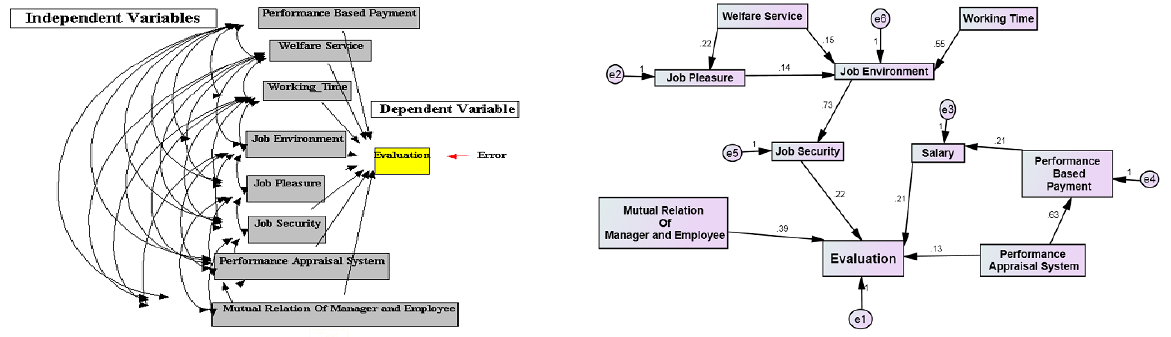
Fig. 1. The proposed framework of the